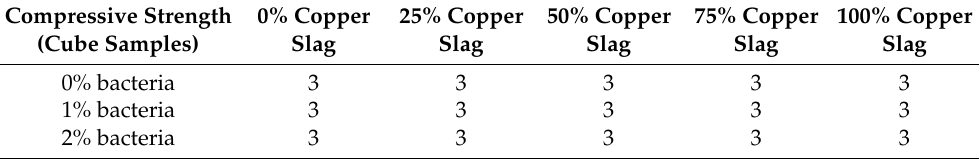
Table 6. Number of cube samples prepared for compressive strength evaluation on day